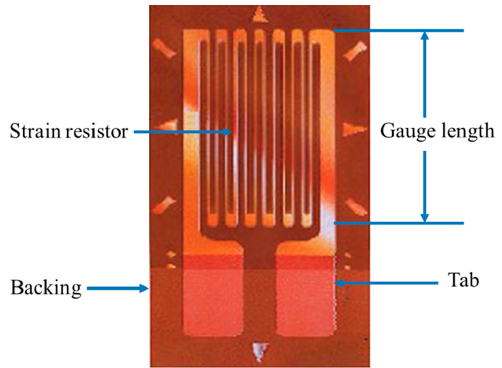
Figure 2. Traditional strain gauge [78].